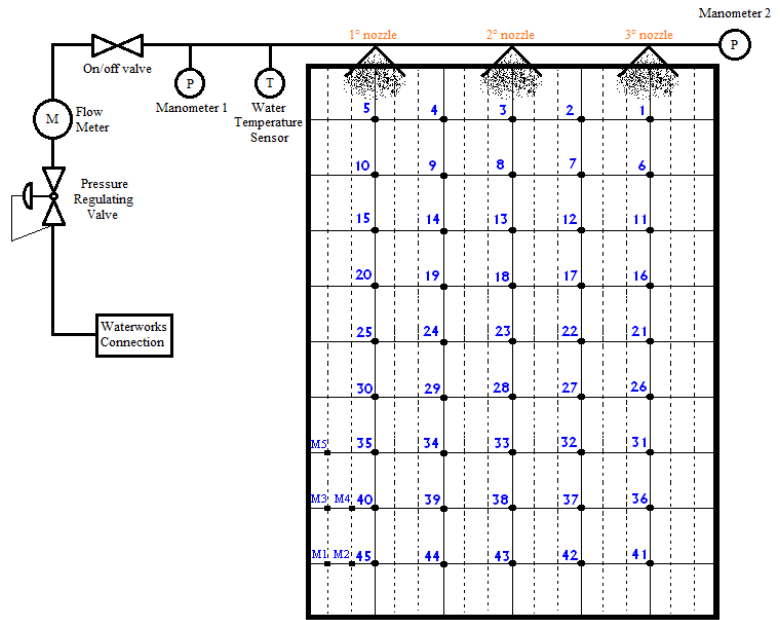
Figure 10. Hydraulic water circuit and thermocouples position on the PV module. Numbers refer to thermocouple name and position on the PV